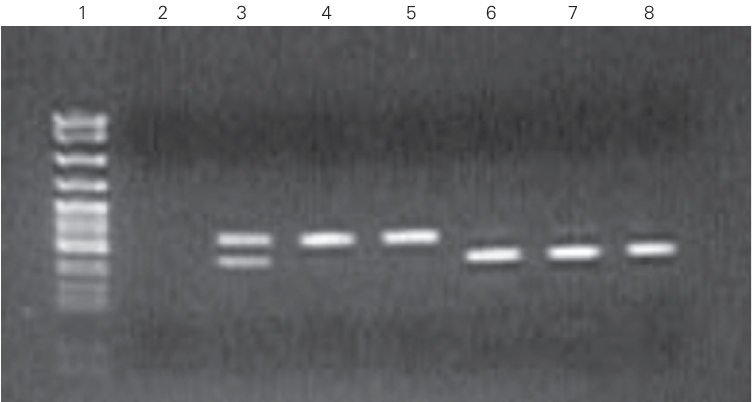
Figure 1. Screening for Fanconi anemia FANCA 3788-3790del mutation. Lane 1 : pBR322; lane 2 : negative control (water); lane 3 : amplification of two bands of a heterozygous individual; lanes 4 and 5 : amplification of the upper band of homozygous individuals; lanes 6-8 : amplification of the lower band of